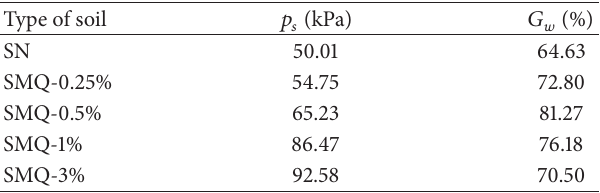
Table 5: 𝑝 𝑠 and 𝐺 𝑤 values presented by soil modified with quill. Type of soil